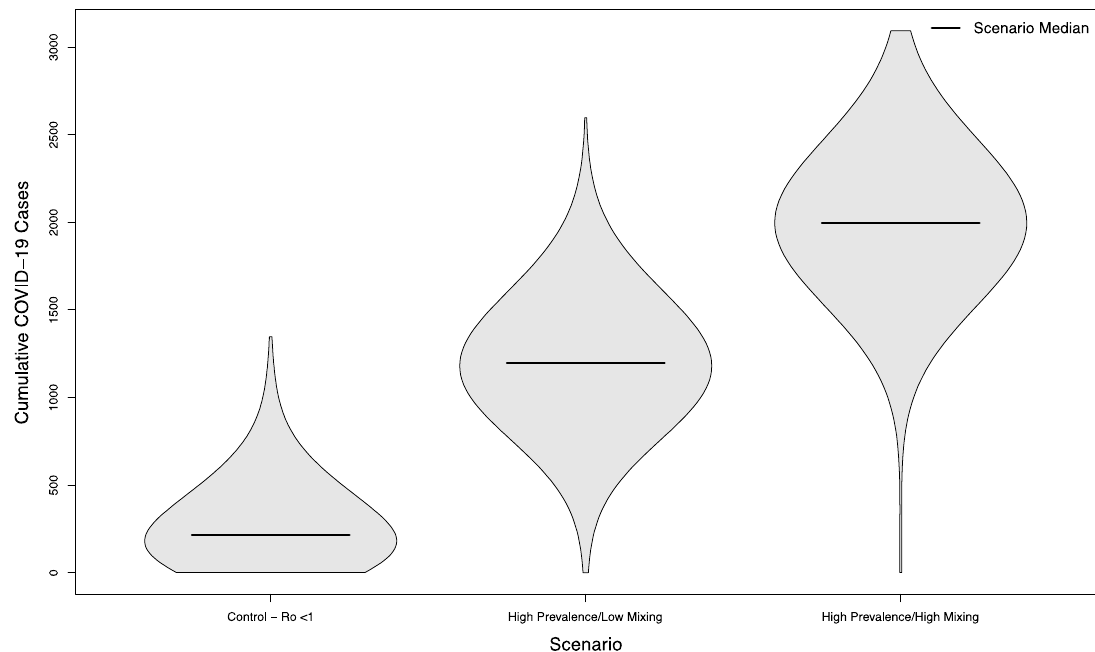
Figure 4. Distribution of cumulative COVID-19 cases in 1000 simulated university campuses with controlled epidemics, comparing a campus with no in-person sporting events to two scenarios where visitors come from a high prevalence area and mix with the campus community at a low rate or a high rate,